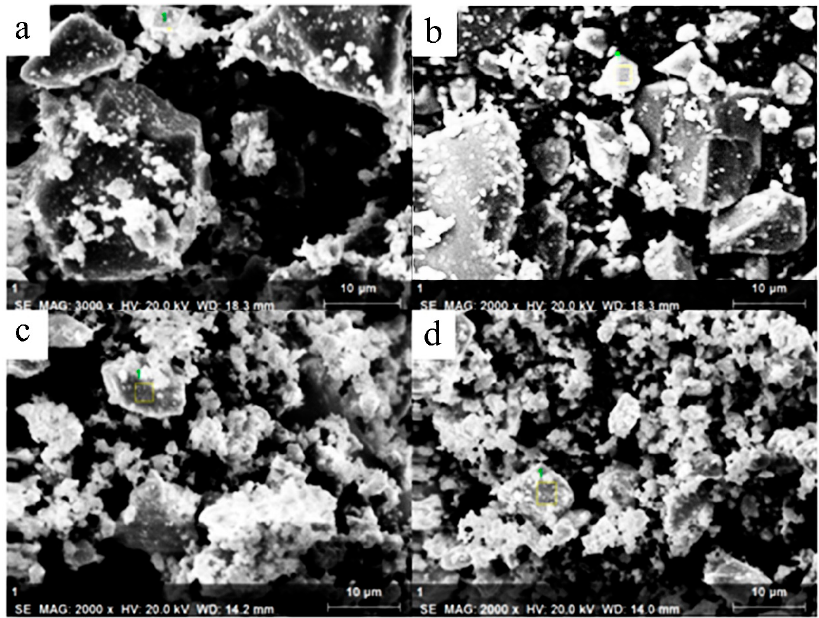
Table 2. EDS result of samples S2, S3, S5 and S7 and the mole ratios of Cu/(Cu + Co). Samples